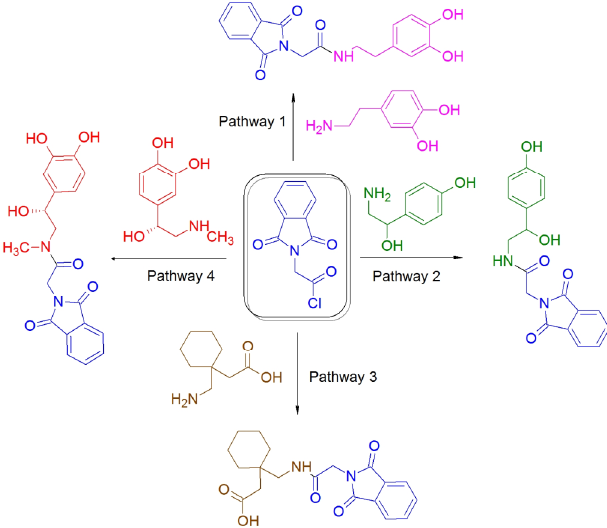
Figure 1. Scheme of catecholamines derivatization with phthalylglycyl chloride (pathway 1—dopamine, pathway 2—octopamine, pathway 4—adrenaline) and pathway 3—gabapentin.